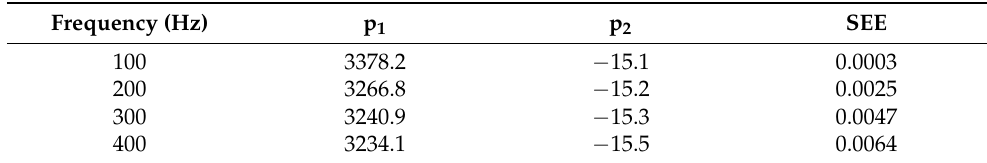
Table 3. Fitting results and